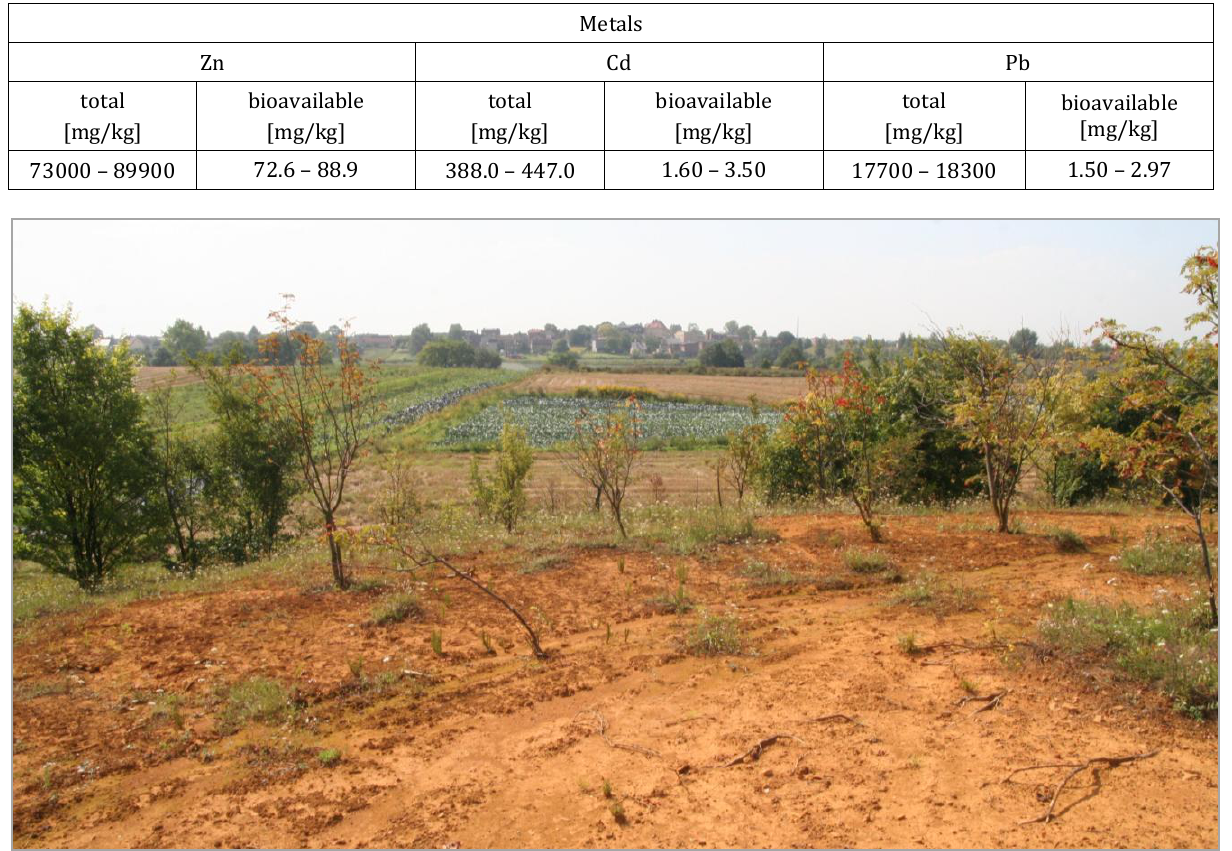
Fig. 5. The top of the "Dołki" spoil heap without vegetation cover ( A. Rostański